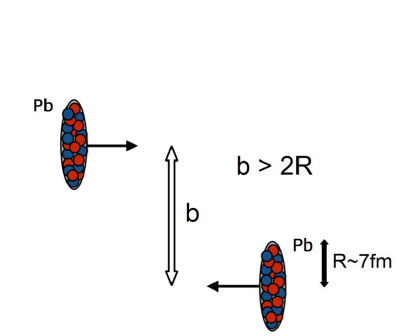
Figure 1. Example of Pb-Pb ultraperiph- eral collision. Pb-Pb collisions occur- ring at an impact parameter b large, say twice the Pb nucleus radius, are not af- fected by strong nucleon-nucleon interac- tions and they are called Ultra Peripheral Collisions.